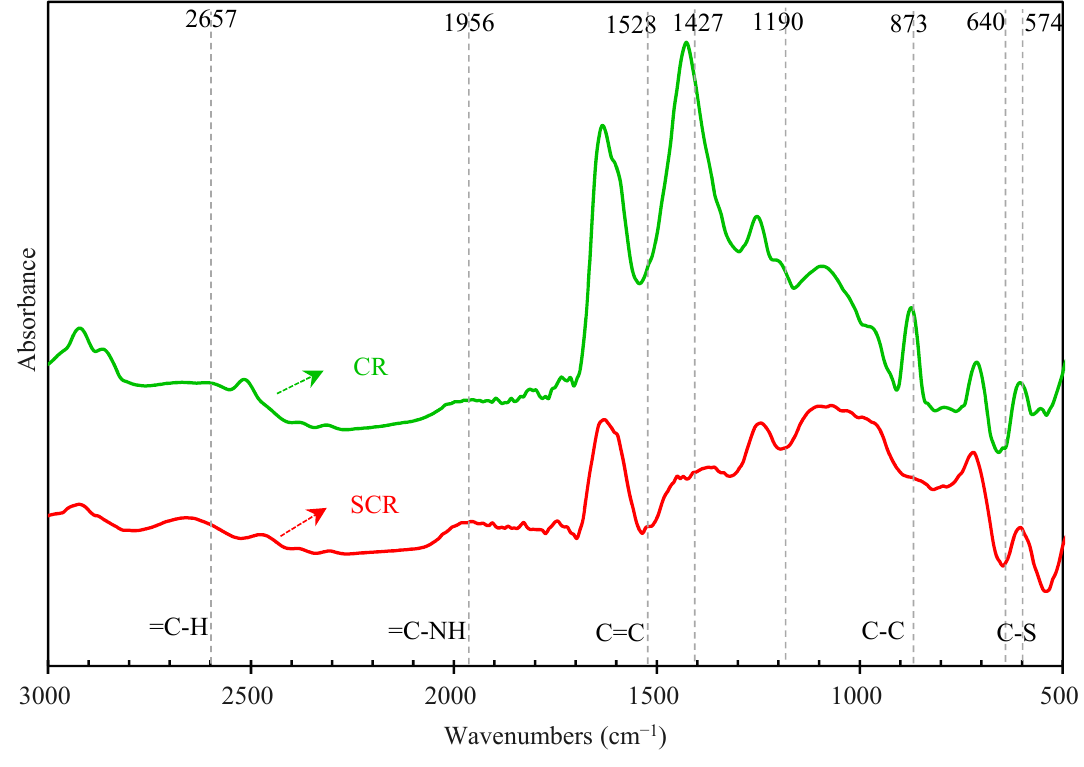
Figure 15. Infrared spectrum of CR and SCR.